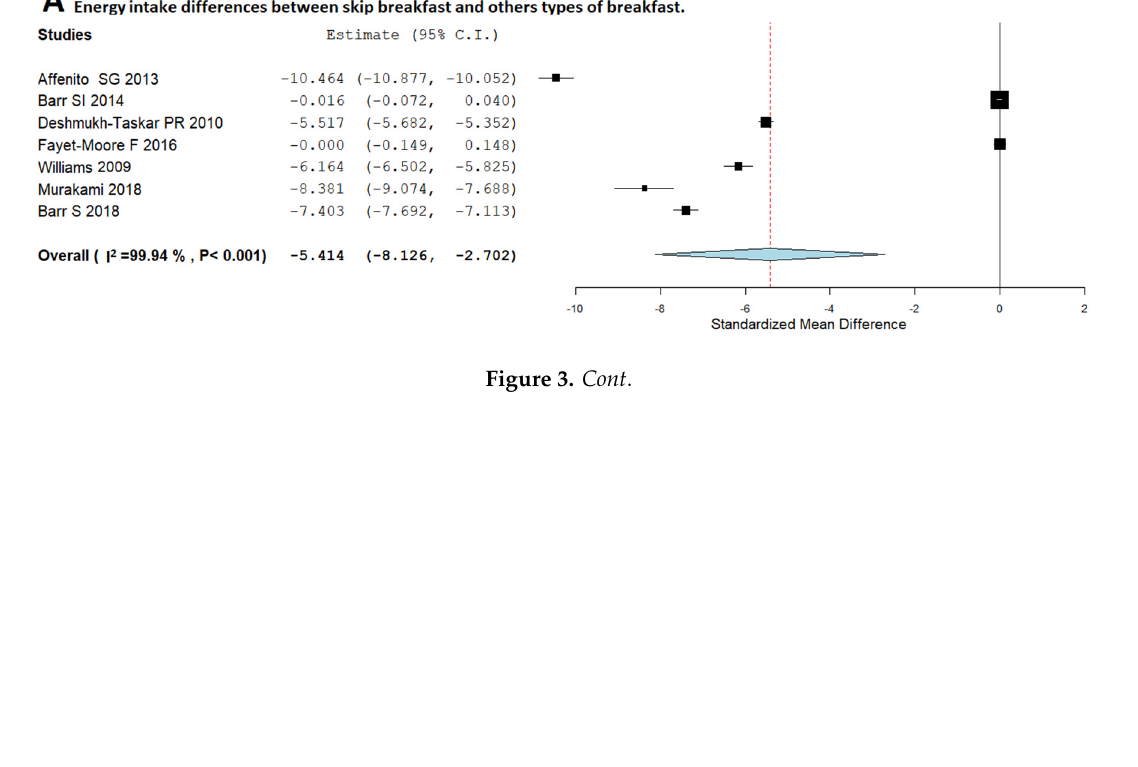
Figure 2. Random-effects meta-analysis of the effects of relationships between skipping breakfast and RTEC breakfast regarding energy ( A ), carbohydrates ( B ), fibre ( C ), protein ( D ) and fat ( E ) intake.